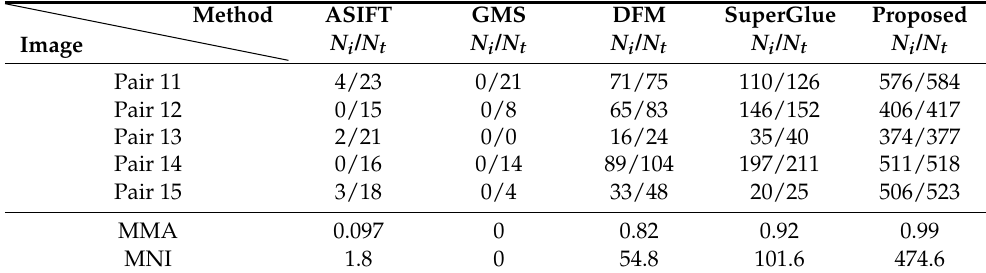
Table 4. Quantitative results of the different methods on dataset SDUST-AB.